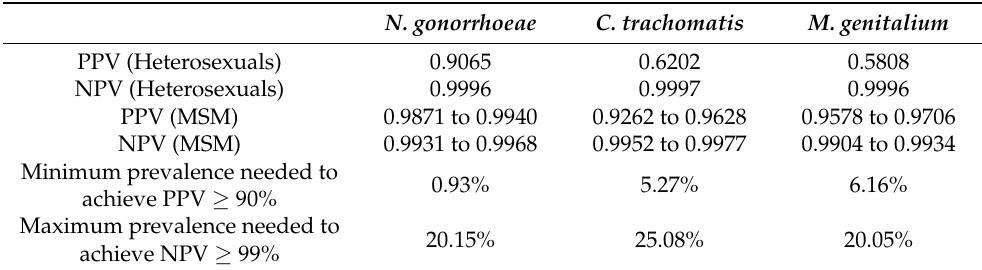
Table 2. Predictive values of screening tests based on the assumptions from Table 1.